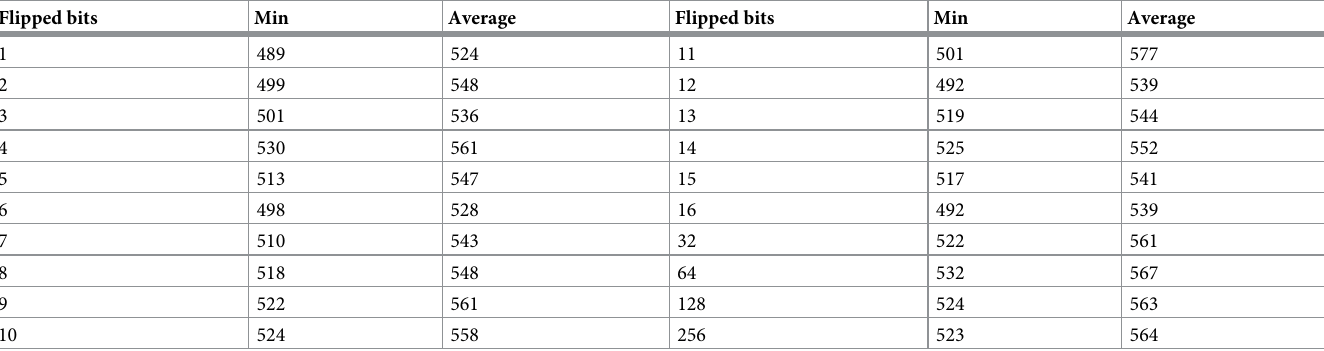
Table 3. Avalanche effect of dual diffusion